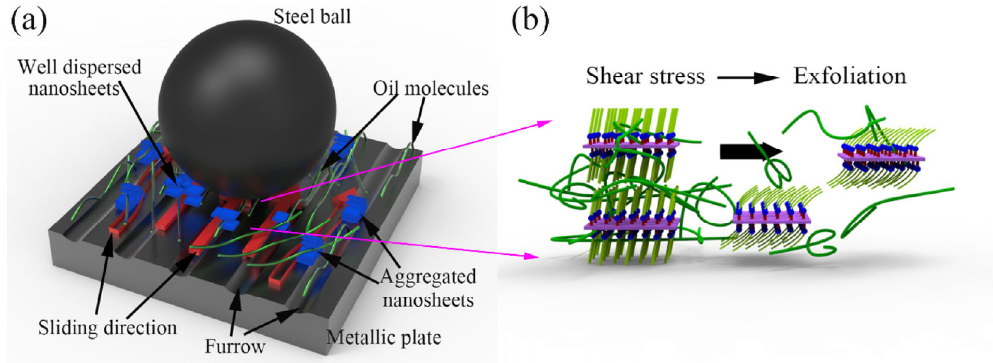
Fig. 12 Schematics showing (a) the effect of dispersion state on lubrication performance and (b) the exfoliation mechanism for the well-dispersed